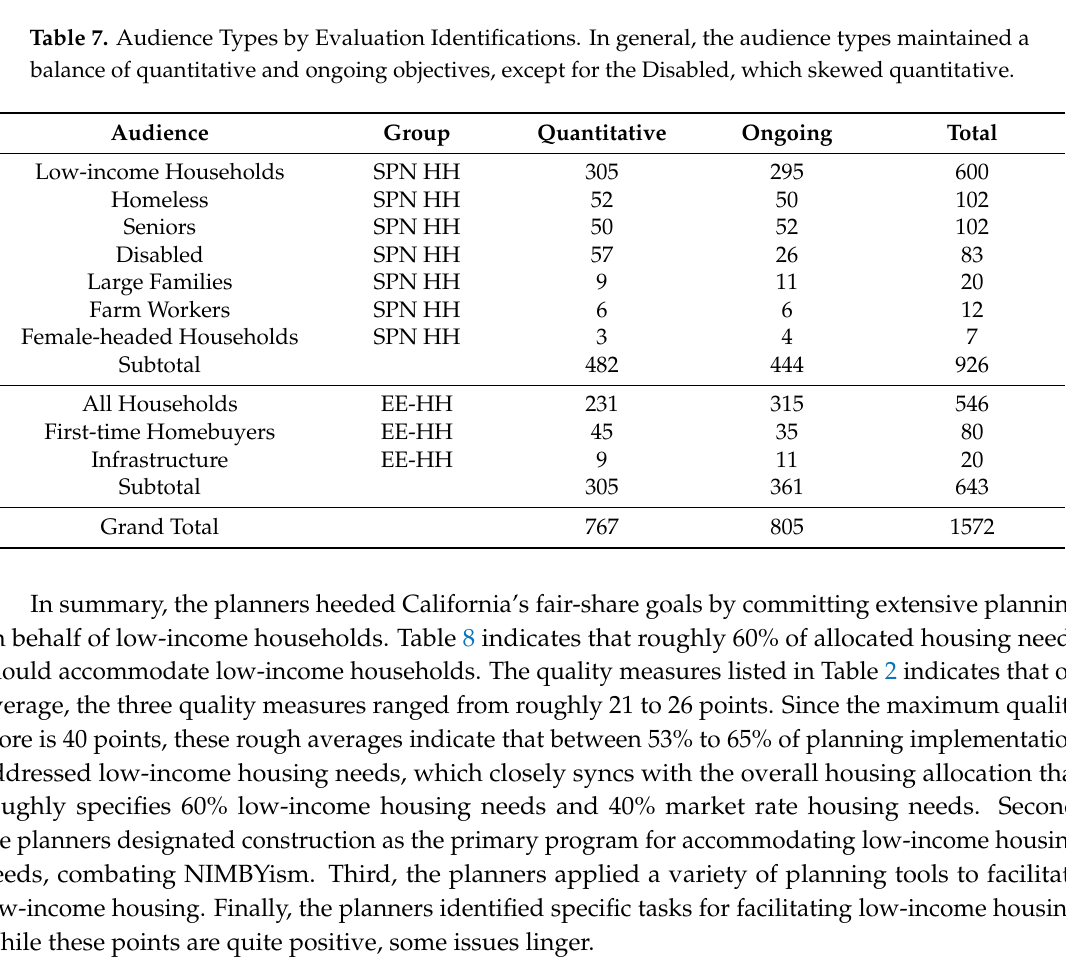
Table 8. Housing Allocation by Units Constructed ( n = 43, 1998–2005). Regarding housing production, the sample produced roughly 40% of its low-income allocation, in contrast to roughly 163% of its market-rate